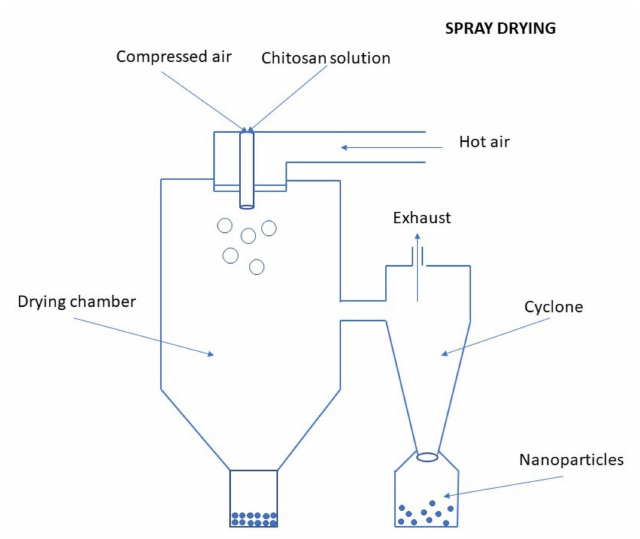
Figure 9. Preparation of CS NPs by the spray-drying